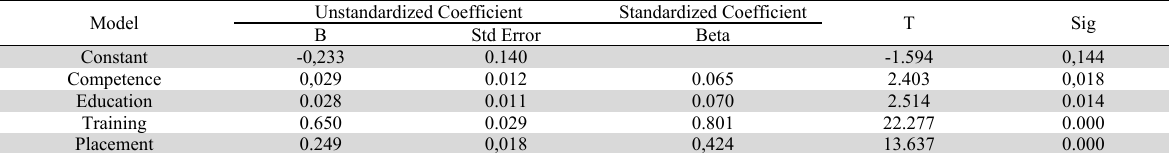
The Influence of Independent Variable on Dependent